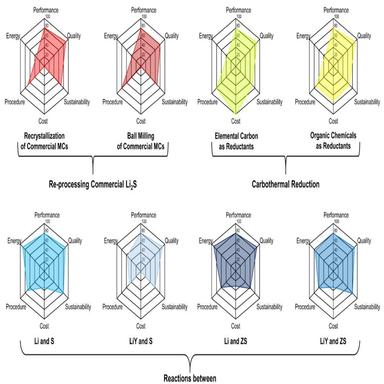
Radar plots for 8 different methods of synthesizing Li2S-NCs, according to six criteria of performance, quality, energy, procedure, cost, and sustainability. In all evaluations, bigger index values mean better evaluation performance. Similar colours (red, yellow, and blue) of the radar represent the subgroups belonging to the same category.